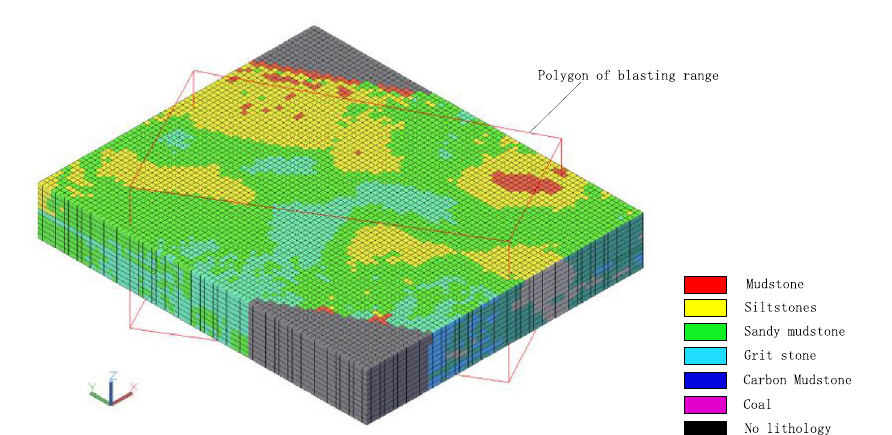
Figure 7. Interpolated three-dimensional solid model.